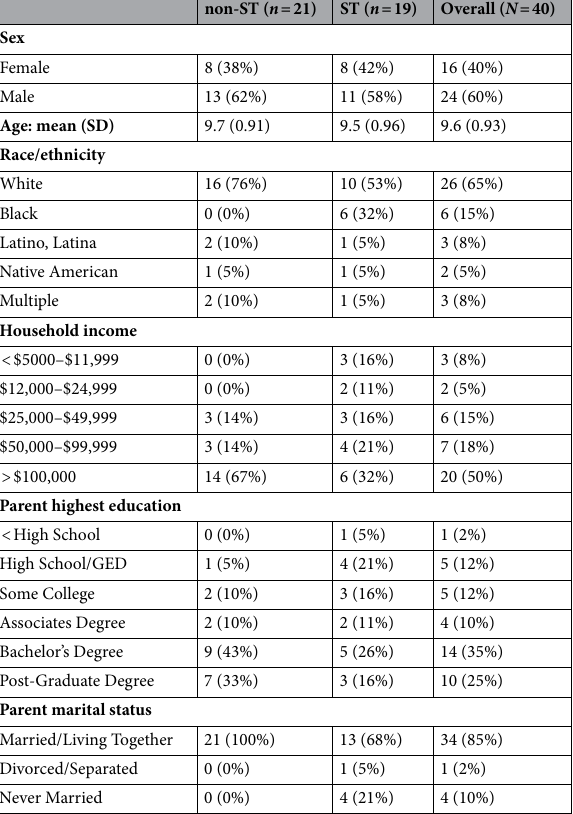
Table 1. Proportions and means/standard deviations for sample demographics by phenotype. Sample demographics divided by phenotypic group (ST and non-ST) and total Participants (Overall). Numbers indicate frequencies with percentages in parentheses unless otherwise indicated as a mean with standard deviation in